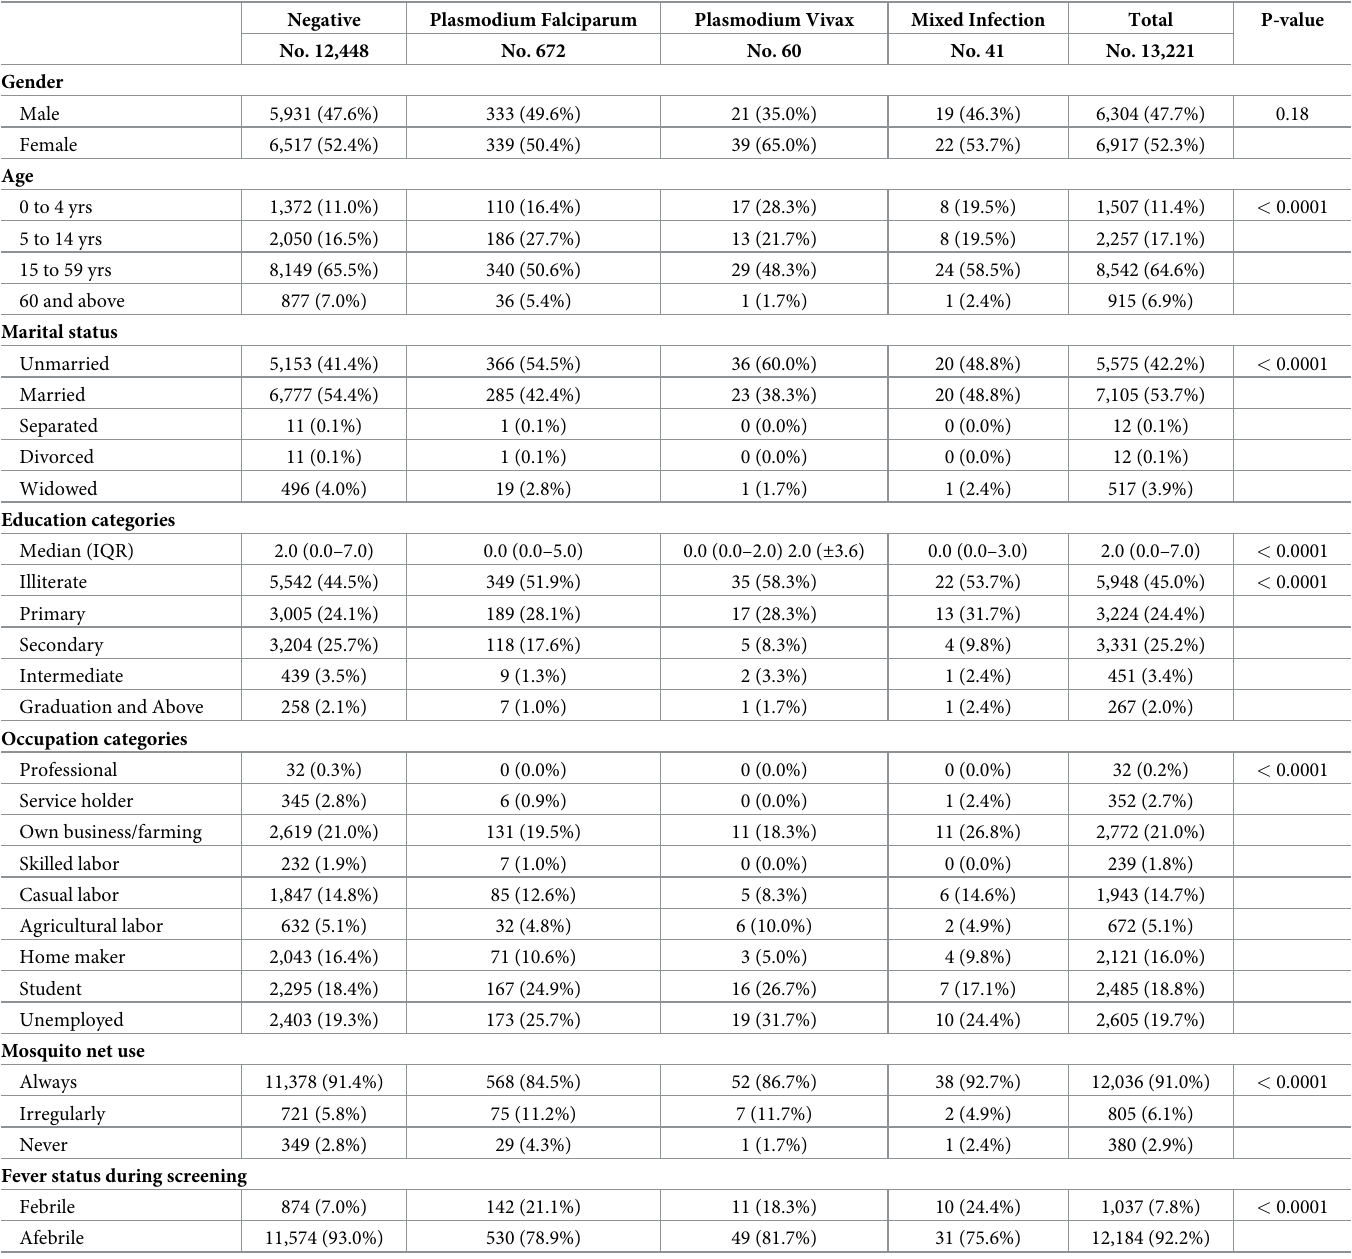
Table 2. Individual demographic